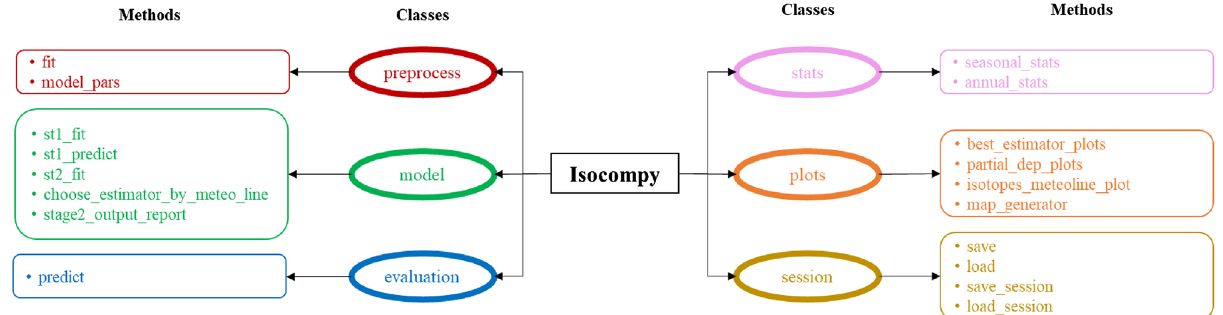
Figure 4. The Isocompy algorithm architecture. It contains 6 classes and 18